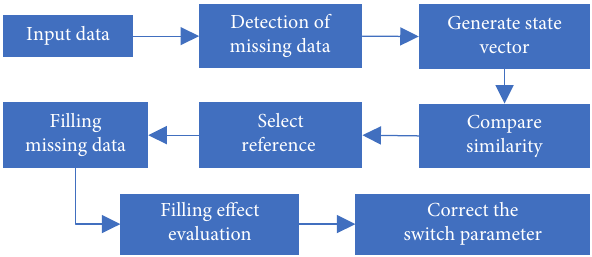
Figure 1: Brief flow chart of the filling